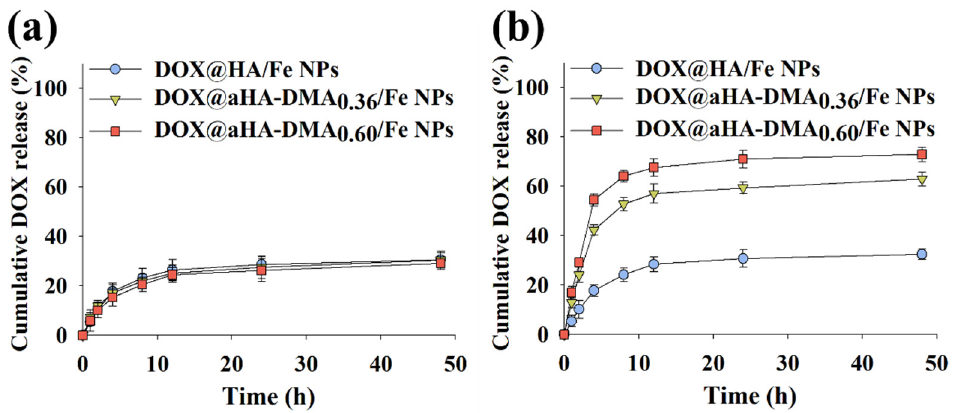
Figure 2. Cumulative DOX release profiles of DOX@HA/Fe NPs, DOX@aHA-DMA 0.36 /Fe NPs,